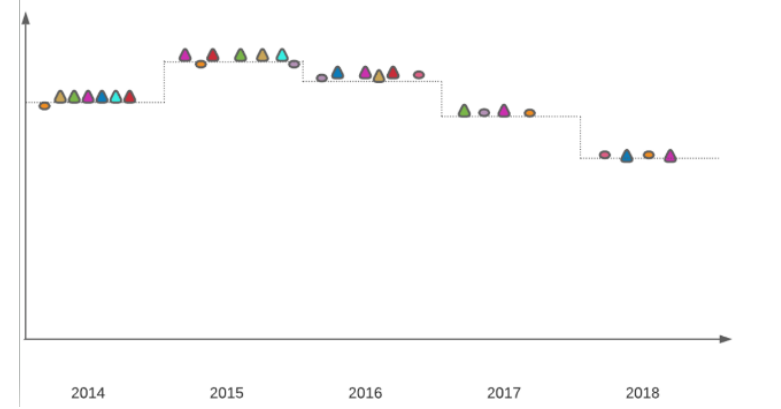
Figure 5: Intensification of Tension between the West and Russia According to the Chronology of Historical Milestones (Source: Authors‟ depiction based on the registry of publications on the websites of both media) The axe X represents the years, and the axe Y points to intensifying the tension between Russia and the West. There are 9 categories of events identified by circles, which are events with a minor level of tension, and triangles when the tension is higher: 1° cultural event (orange circle), 2° sabotage and blockades (red triangle), 3° strategic partnership (light blue triangle), 4° economic sanctions (green triangle), 5° cooperation/support/dialogue (purple circle), 6° diplomatic sanctions (yellow triangle), 7° litigation (blue triangle), 8° provocations and threats (fuchsia triangle), and 9° visits of delegates to Crimea (pink circle). This chronology is based on the events that came up from the coverage of Sputnik and RT during the 2014-2018 period, which was summarized in the second section of this paper.